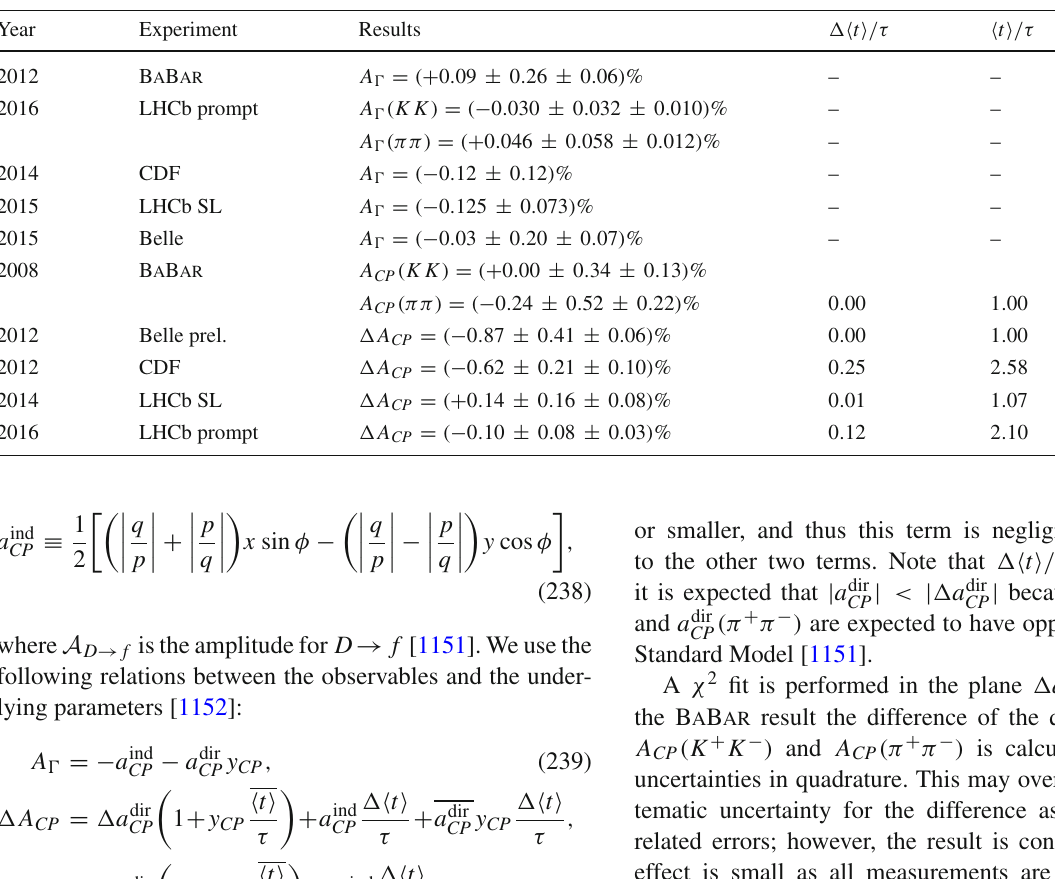
Table 269 Measurements of the T -odd asymmetry A